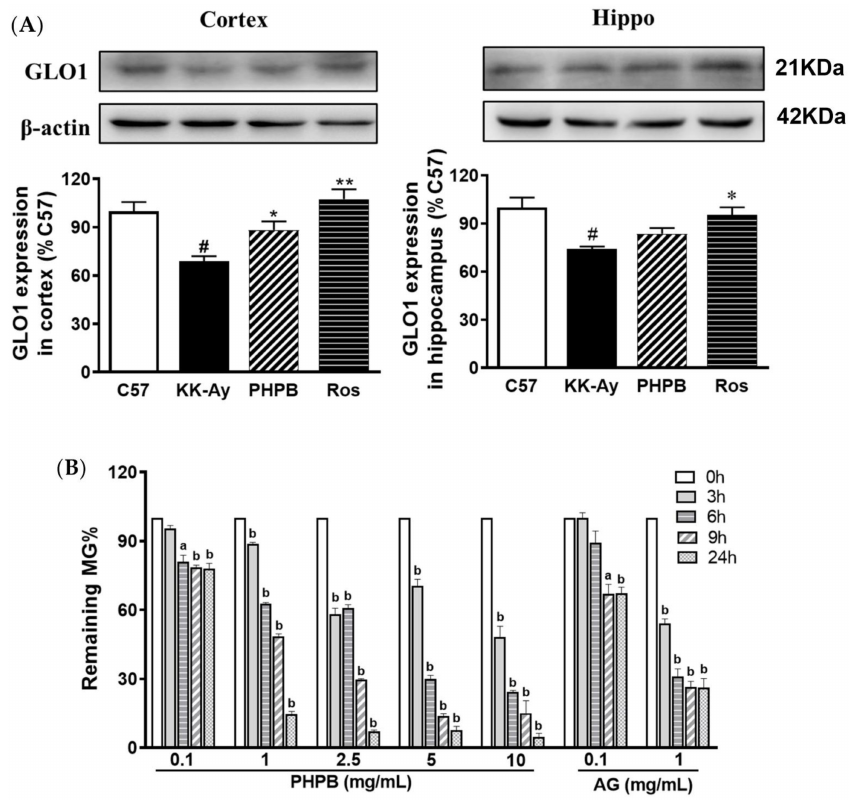
Figure 6. PHPB attenuated MG through up-regulating GLO1 protein and enhancing MG trapping. ( A ) Western blotting was used to detect the protein expressions of GLO1 in the cortex and hippocam- pus of mice treated with PHPB (150 mg/kg) or rosiglitazone (Ros, 5 mg/kg) for two months, and densitometric quantification of them, n = 8 for each group. ( B ) MG trapping of PHPB was detected